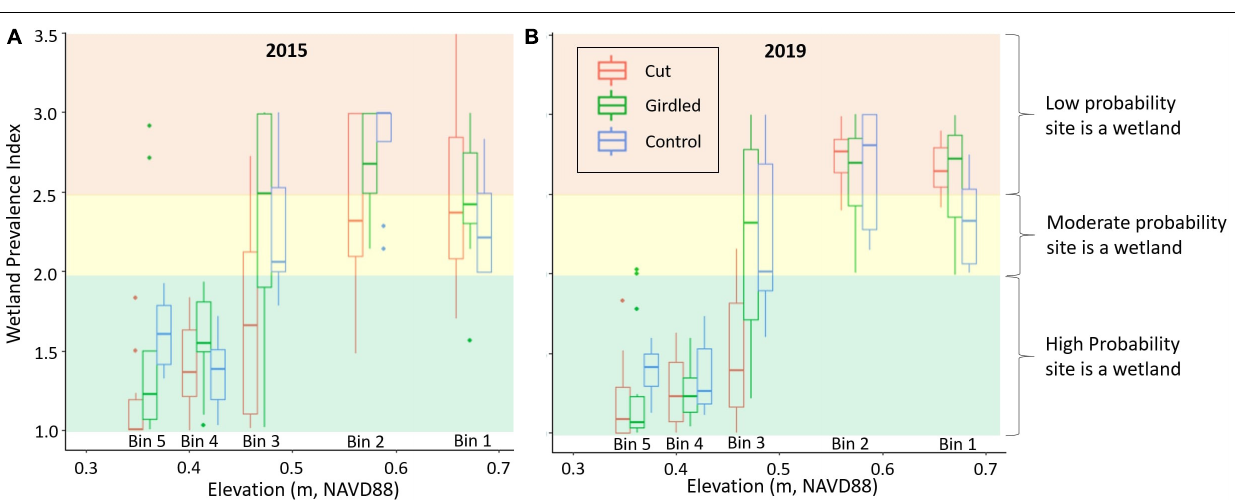
FIGURE 6 | Wetland vegetation dynamics as a function of elevation and forest disturbance with Prevalence Index (PI) for the occurrence of hydrophytic vegetation versus elevation, color-coded by treatment area for (A) the first year of the experiment (2015) and (B) the last year (2019). PI values greater than 2.5 indicate a low probability a site is a wetland, values between 2 and 2.5 indicate a good probability that a site is a wetland, and values less than 2 indicate a high probability that a site is a wetland. Boxplot centerline represents the median value of the data, the upper and lower box sides represent the 25th and 75th percentile datapoints, the whiskers extend to the largest and smallest values within the 1.5 interquartile range of the 25th and 75th percentile, and all remaining points are plotted as